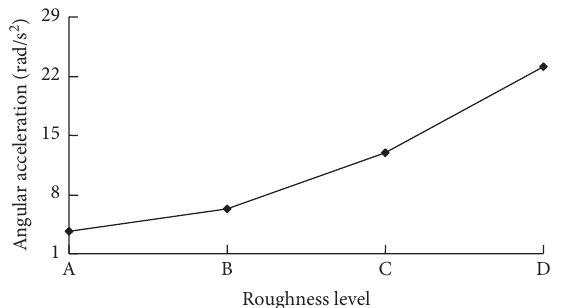
Figure 13: The variation curve of peak values of rolling vibration accelerations of the vehicle body.